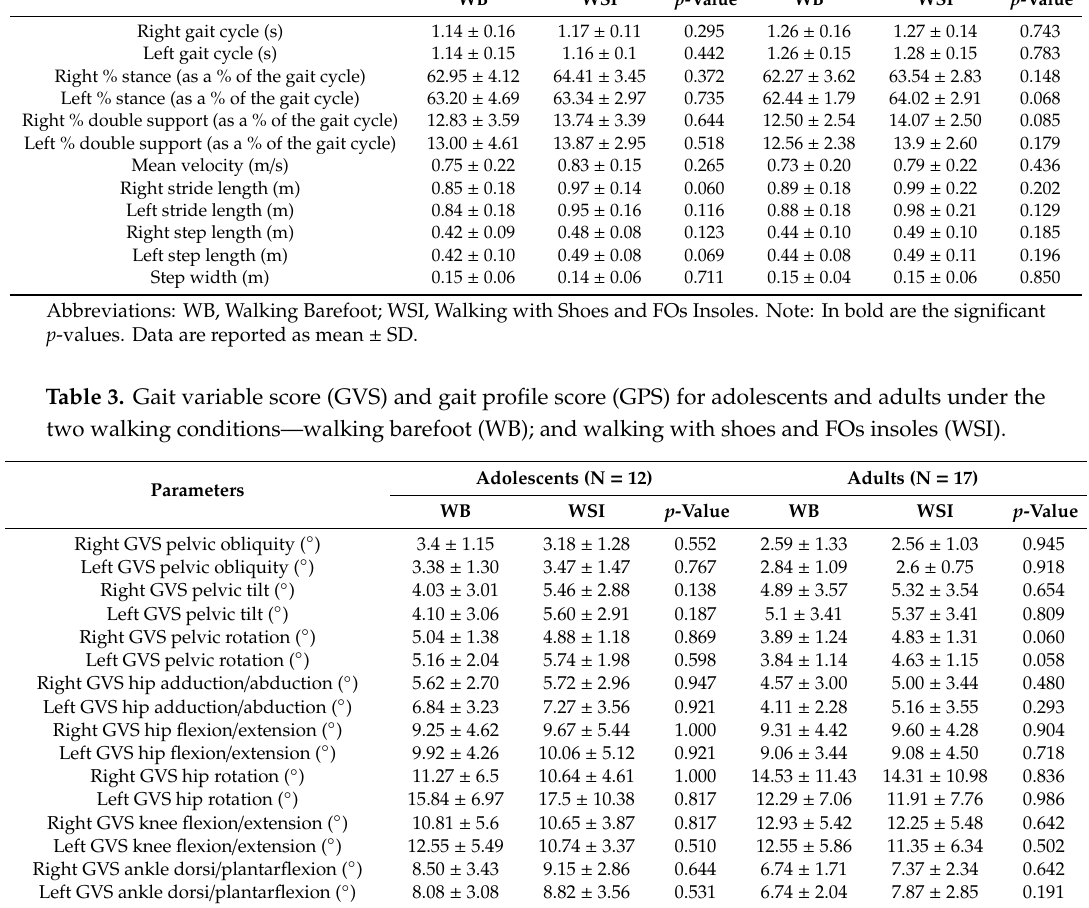
Table 2. Spatio-temporal gait parameters for adolescents and adults under the two walking conditions—walking barefoot (WB) and walking with shoes and FOs insoles (WSI). Parameters